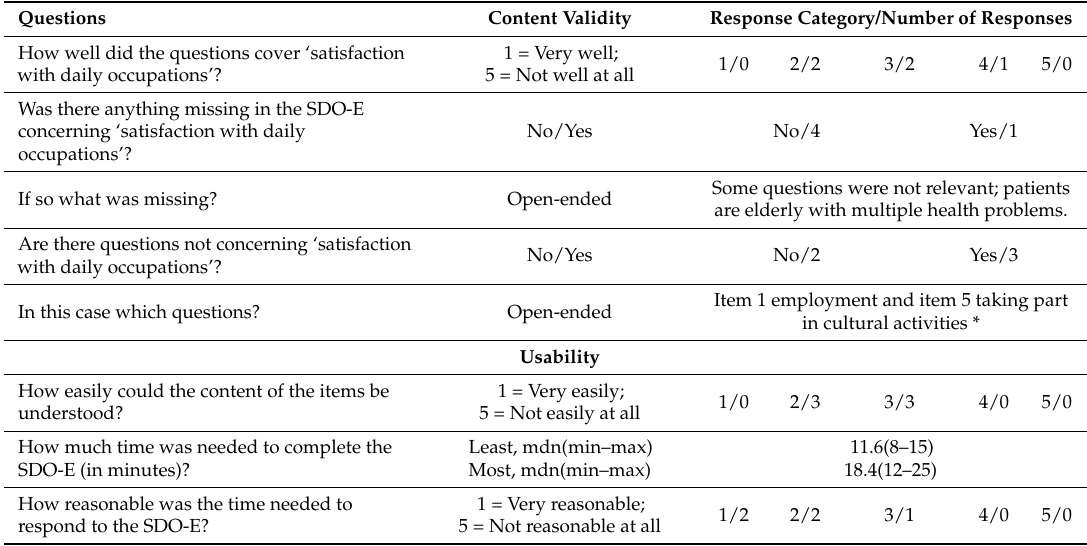
Table 4. Response distribution for the questionnaire about content validity and clinical